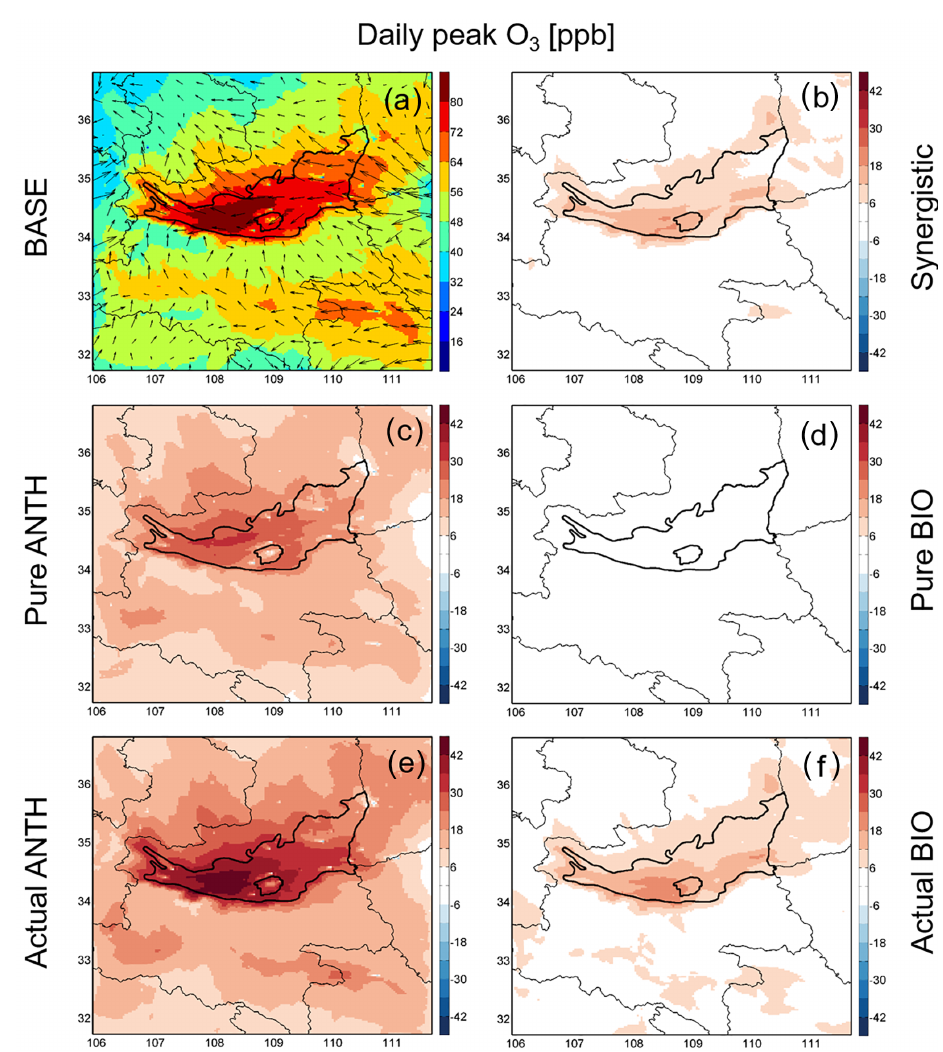
Figure 8. Spatial distributions of monthly mean concentrations of daily peak O 3 in August 2011. Panel (a) is the result from the BASE simulation, overlaid with simulated wind vectors. Panels (b–f) are simulated daily peak O 3 concentrations contributed from synergistic anthropogenic and biogenic, pure anthropogenic, pure biogenic, actual anthropogenic, and actual biogenic sources, respectively.